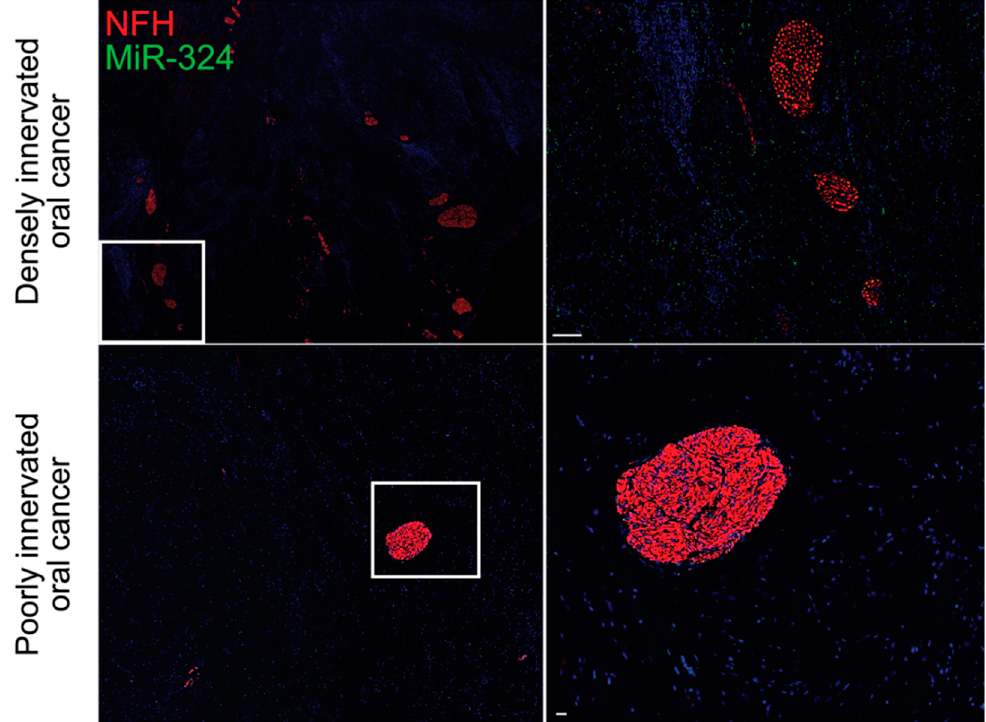
Figure 2. MiR-324 is enriched in densely innervated oral tumors. MiR-324 promotes neuritogenesis within oral tumors, as evidenced by the increased amount of miR-324 in the densely innervated oral tumors (top) when compared with the poorly innervated oral tumors (bottom). Data are original to this manuscript. NFH, neurofilament H. Top scale bar is 100 μ m. Bottom scale bar is 30 μ m.